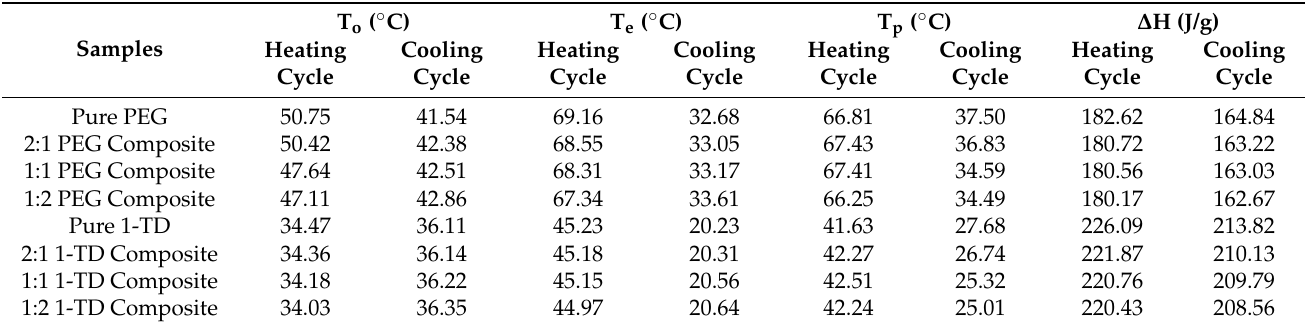
Figure 7. DSC curves of ( a ) pure PEG and PEG composites and ( b ) pure 1-TD and 1-TD composites.